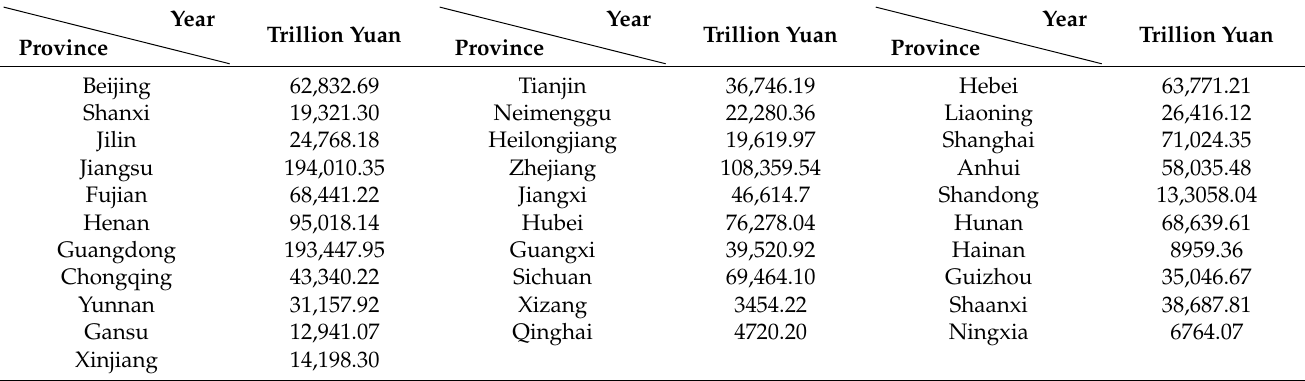
Table 4. A comparison of the GDP forecast of Chinese provinces in 2030 using the ARIMAX